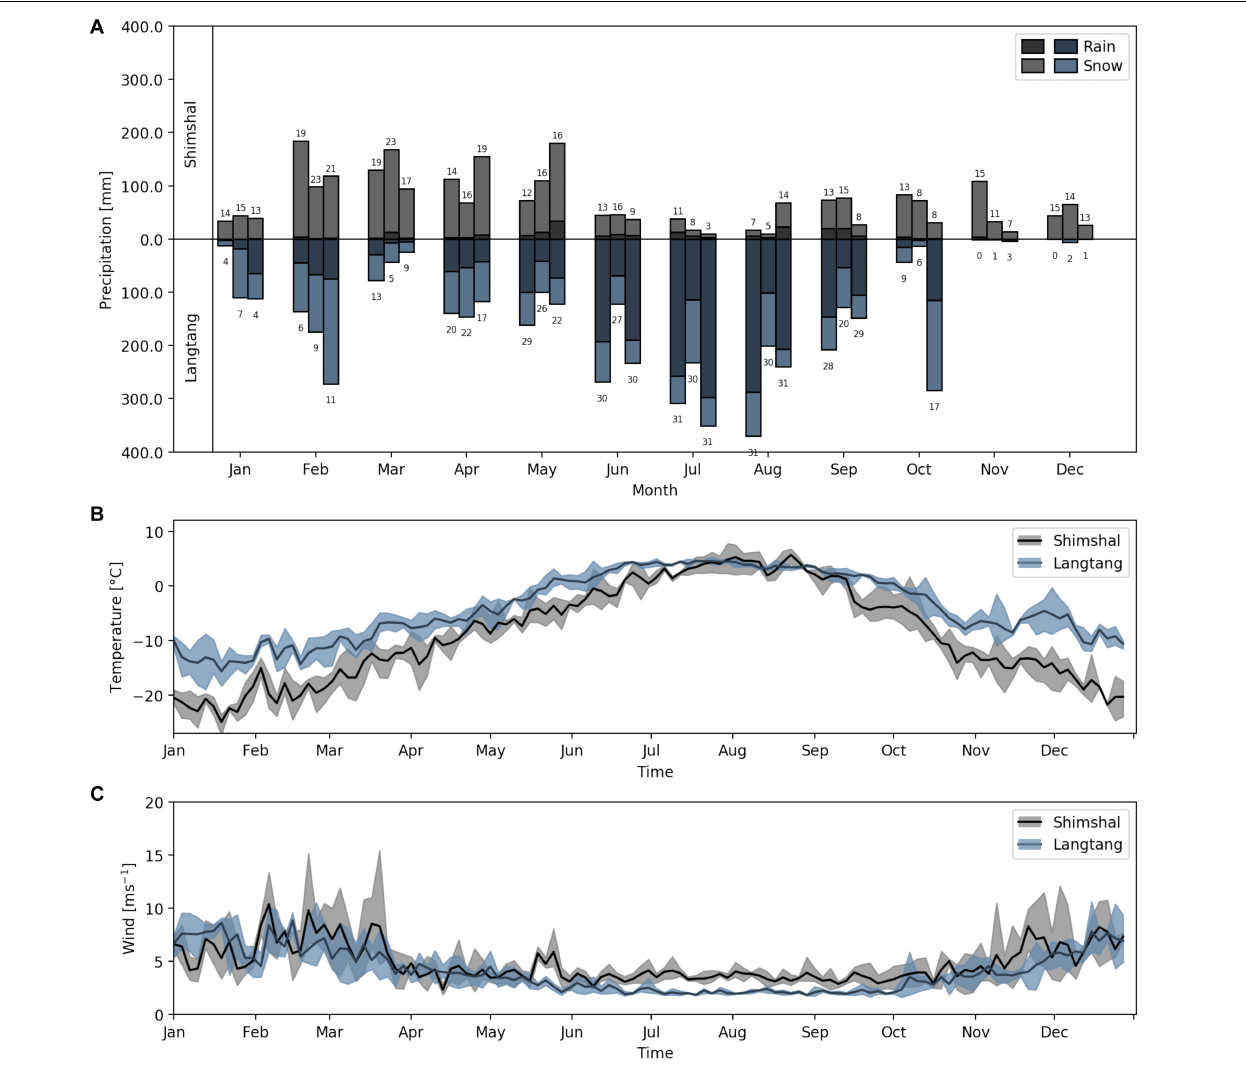
FIGURE 2 | (A) Monthly accumulated catchment-precipitation, with the number of wet days ( P > 0.5 mm/day) for 2011–2013 (one bar per year). (B) Five-day catchment average temperature for the Shimshal (black) and Langtang (blue) catchment. (C) as (B) but for the 10-m wind speed. The shading indicates the minimum and maximum value of the individual